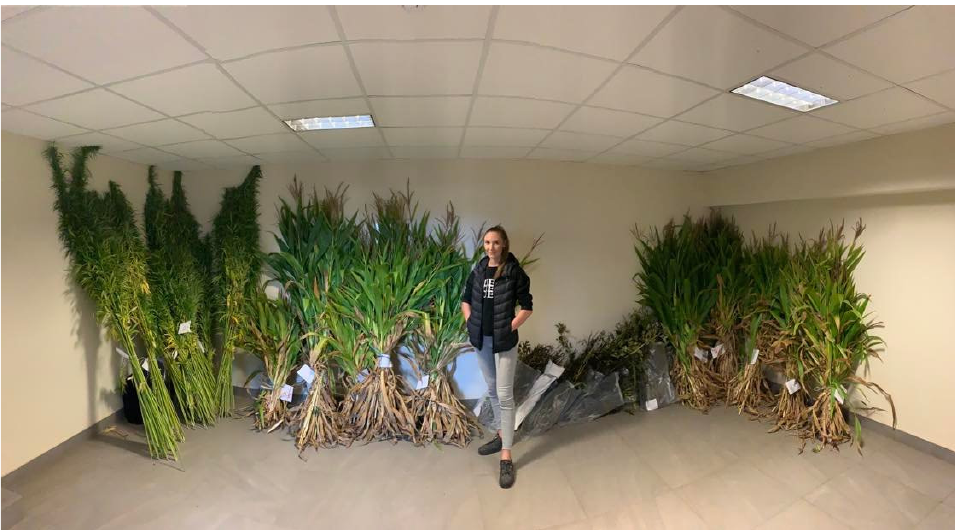
Figure 2. Fresh biomass samples for productivity testing (photographed by Aust ė ja Švereikait ė ).